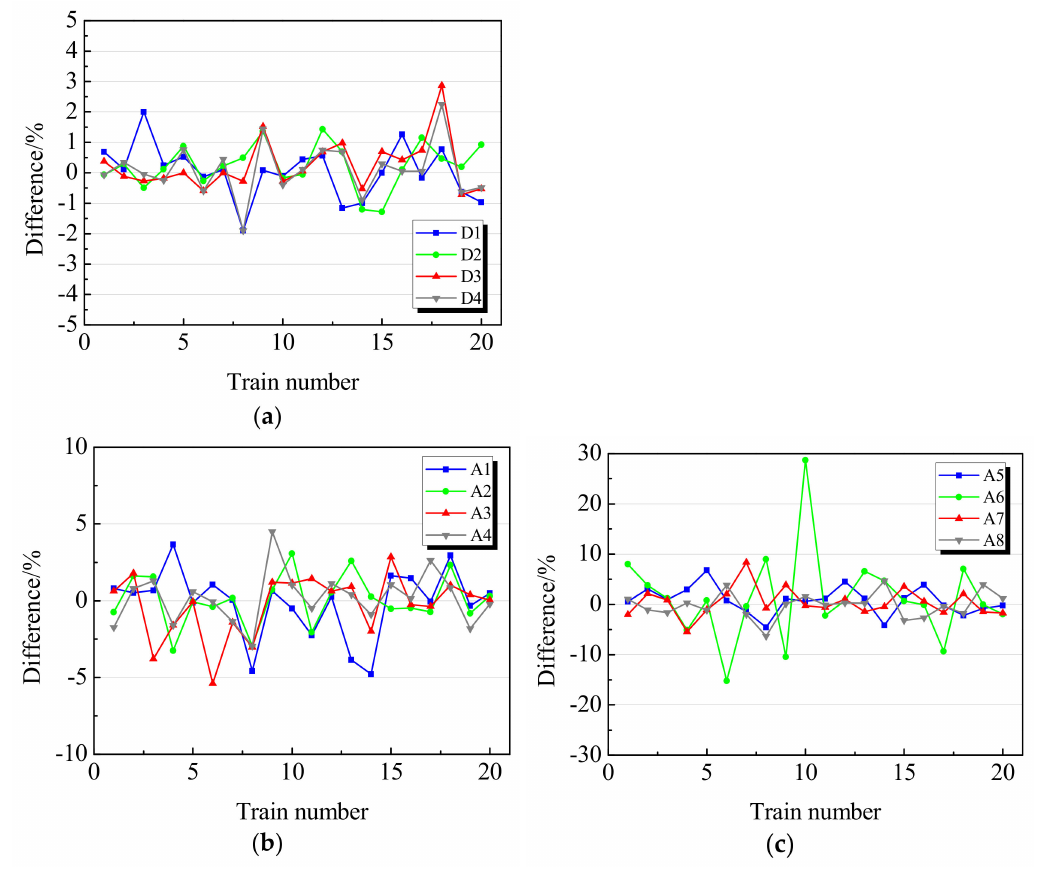
Figure 11. The automatic train speed estimation results of ( a ) the slab displacement, ( b ) the rail acceleration, and ( c ) the slab acceleration,